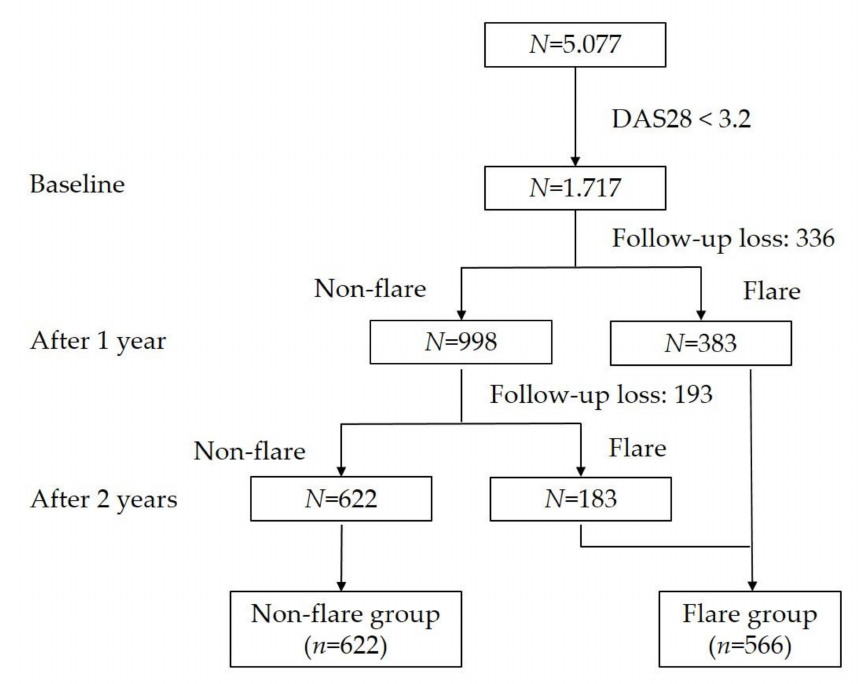
Figure 1. Flow chart of enrolled patients with rheumatoid arthritis during the 2-year study